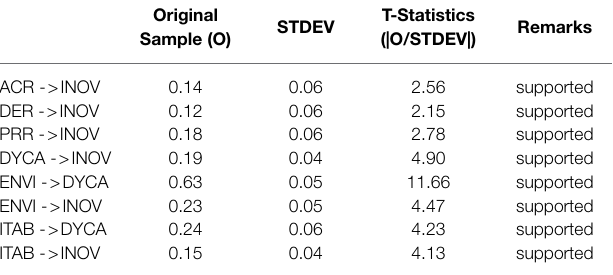
TABLE 3 | Hypothesis